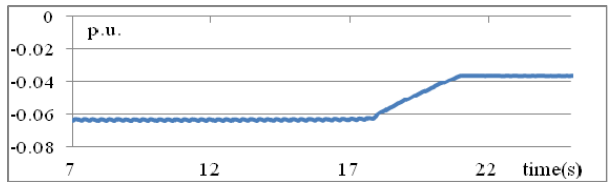
Figure 9. Variations of MW generation from PV (Scenario 2).